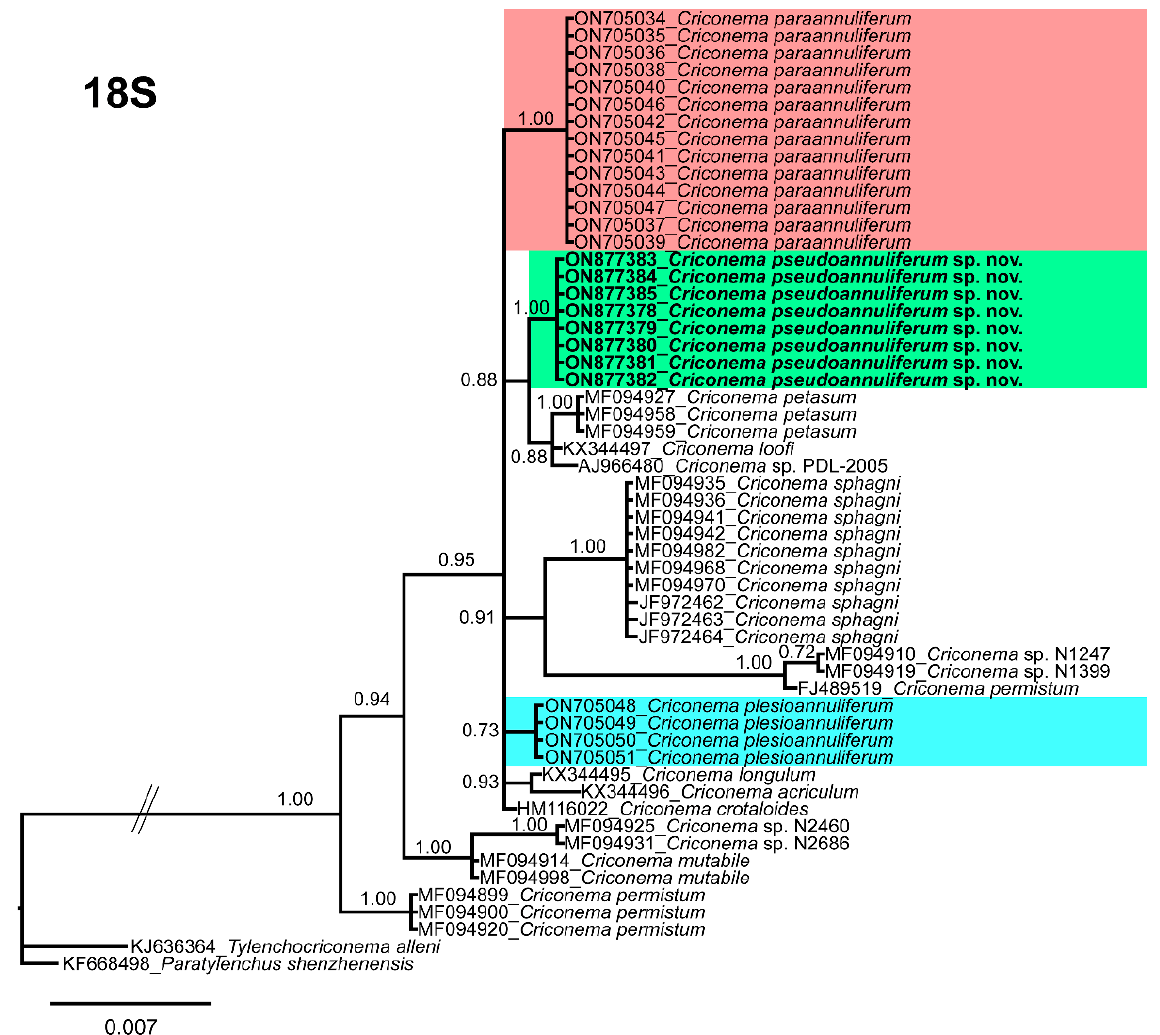
Figure 9. Phylogenetic relationships within the genus Criconema . Bayesian 50% majority rule con- sensus tree as inferred from 18S rRNA sequence alignment under the one-parameter model with invariable sites and gamma distribution model (TPM3uf + I + G). Posterior probabilities of more than 0.70 are given for appropriate clades. Newly obtained sequences in this study are shown in bold. The scale bar indicates expected changes per site, and the coloured boxes indicate the clade association of Criconema annuliferum complex.